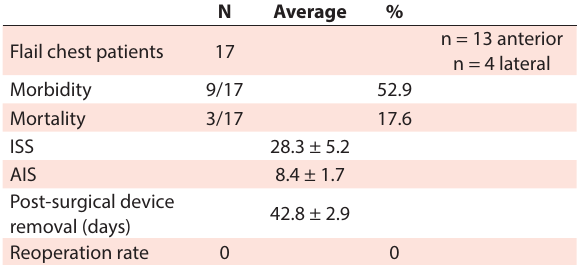
Table 4. Clinical finding and post-operative outcome in flail chest patients undergoing surgical stabilization